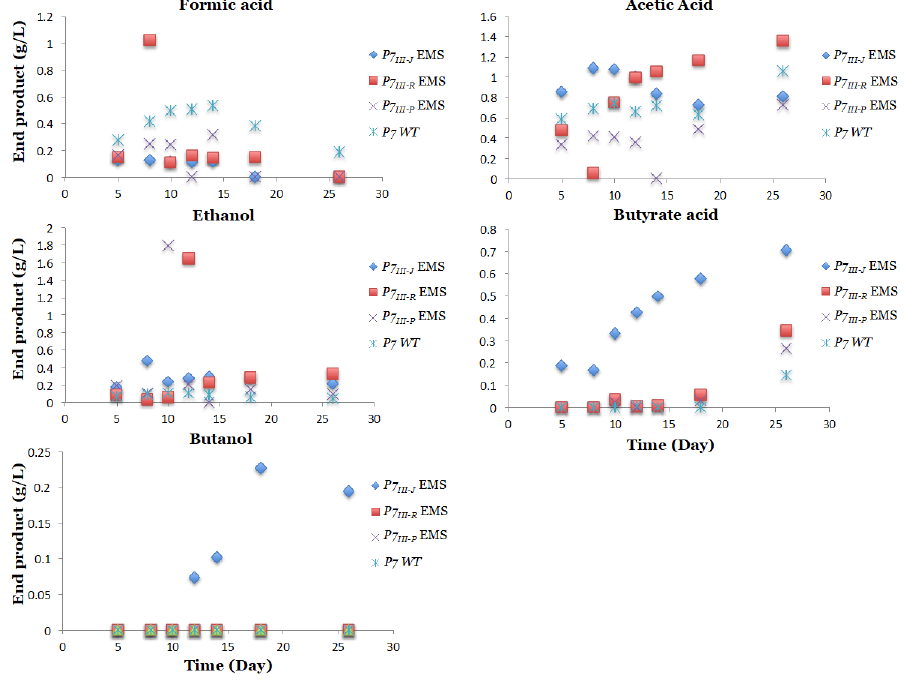
Figure 5. Acid and Alcohol end product (g/L) comparison between the three P7-EMS and the P7-WT. The three P7-EMS mutants ( P7 III-J , P7 III-R , and P7 III-P ) showed decreased formic acid production